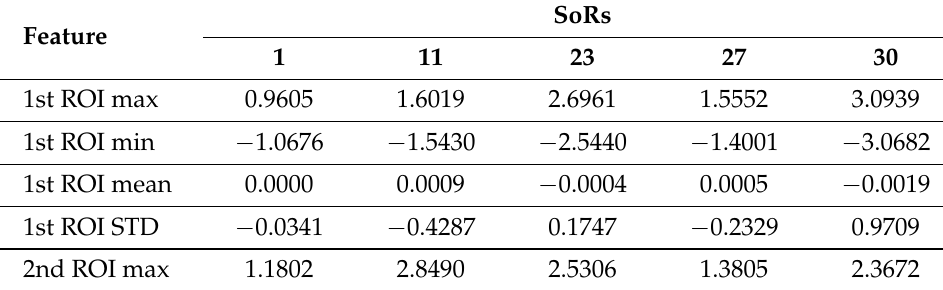
Table 13. Mean values for features on SoRs from ASD